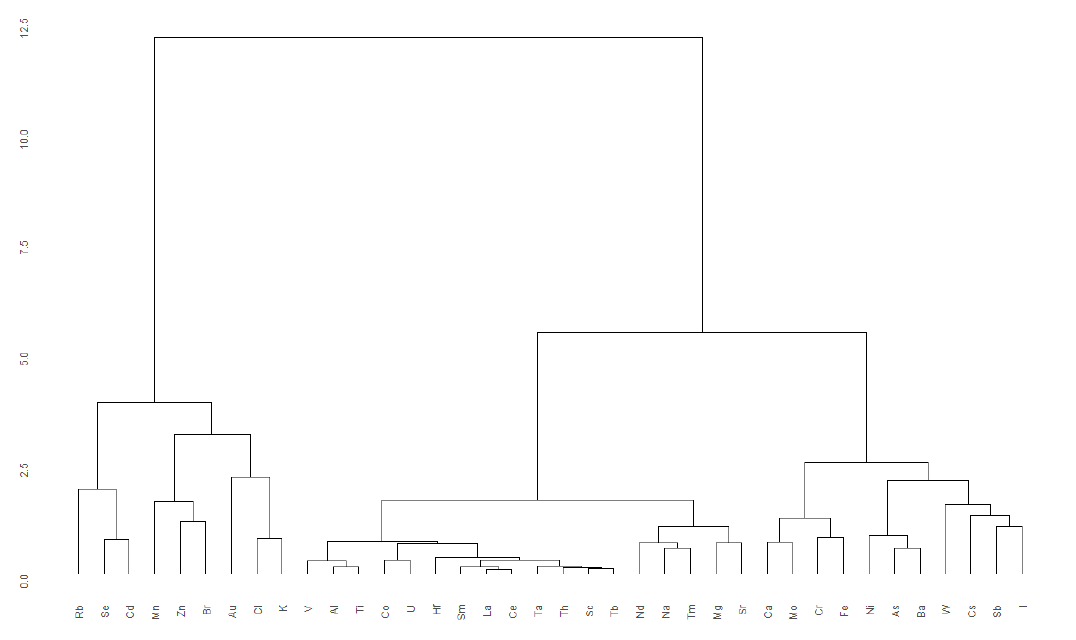
Figure 10. Hierarchical clustering based on a correlation